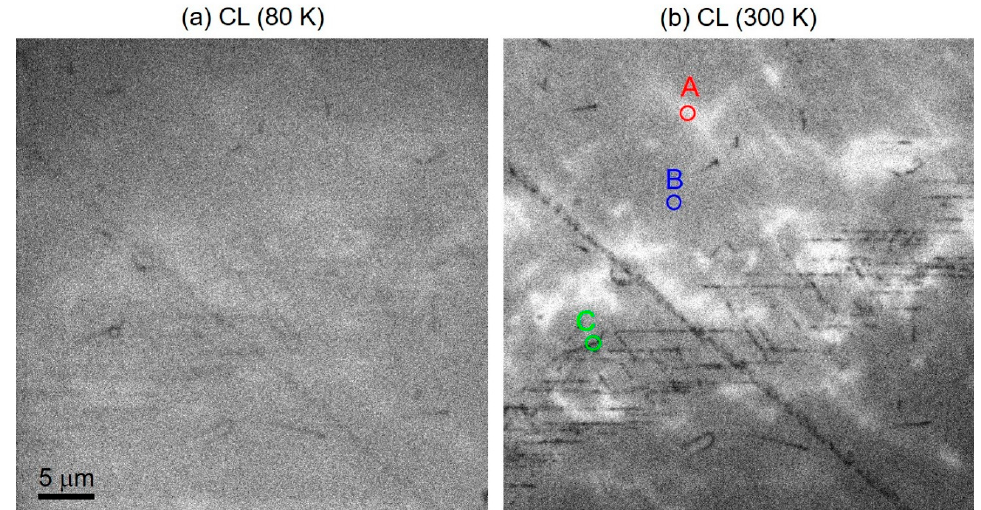
Figure 4. Monochromatic cathodoluminescence (CL) images of dislocations in (110) oriented SrTiO 3 taken at the emission energy of 2.8 eV. ( a ) 80 K and ( b ) 300 K. Site A–C: A—straight line with bright contrast; B—background; C—curved dislocation with dark contrast.